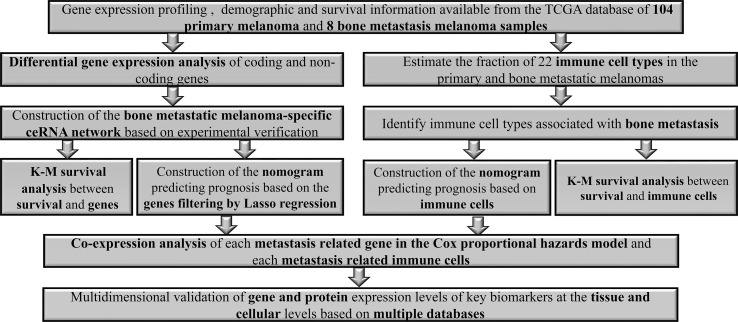
The flowchart of the analysis process.